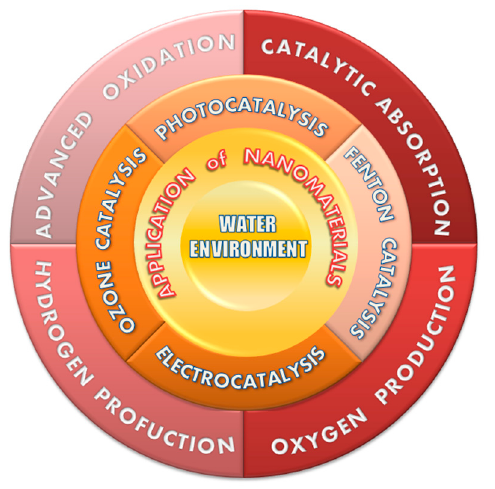
Figure 1. Overview of the application of nanomaterials in the field of water environment.